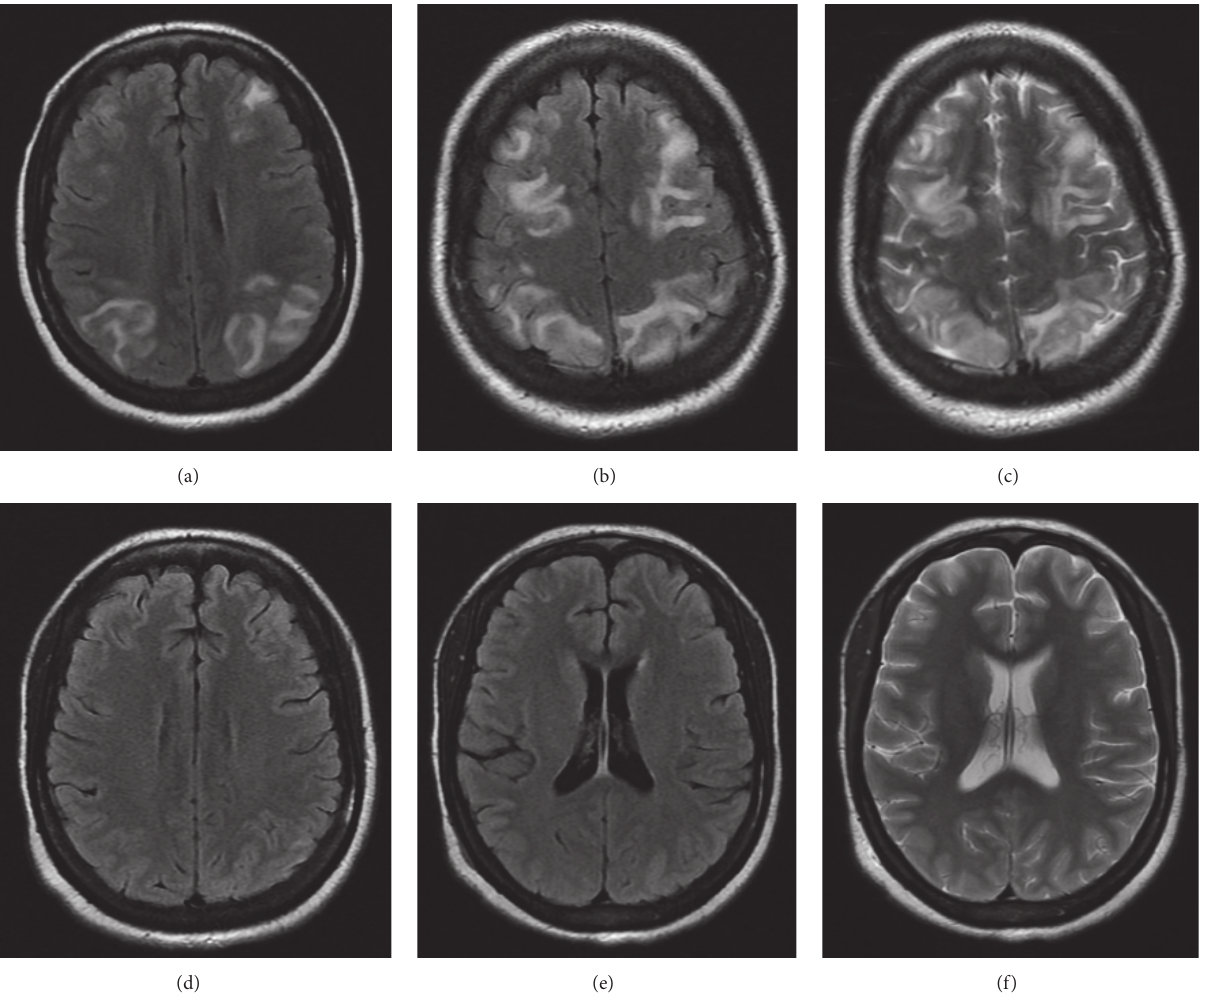
Figure 1: The initial MRI (images (a)–(c)) showed typical holohemispheric involvement: axial view in FLAIR (see (a), (b)) and T2-weighted (see (c)) images with extensive areas of high signal intensity in the subcortical white matter of both parietooccipital regions, including frontal lobes. Second MRI (images (d)–(f)) performed 2 weeks later with no signal abnormality within the brain parenchyma on FLAIR (see (d), (e)) and T2-weighted (see (f))